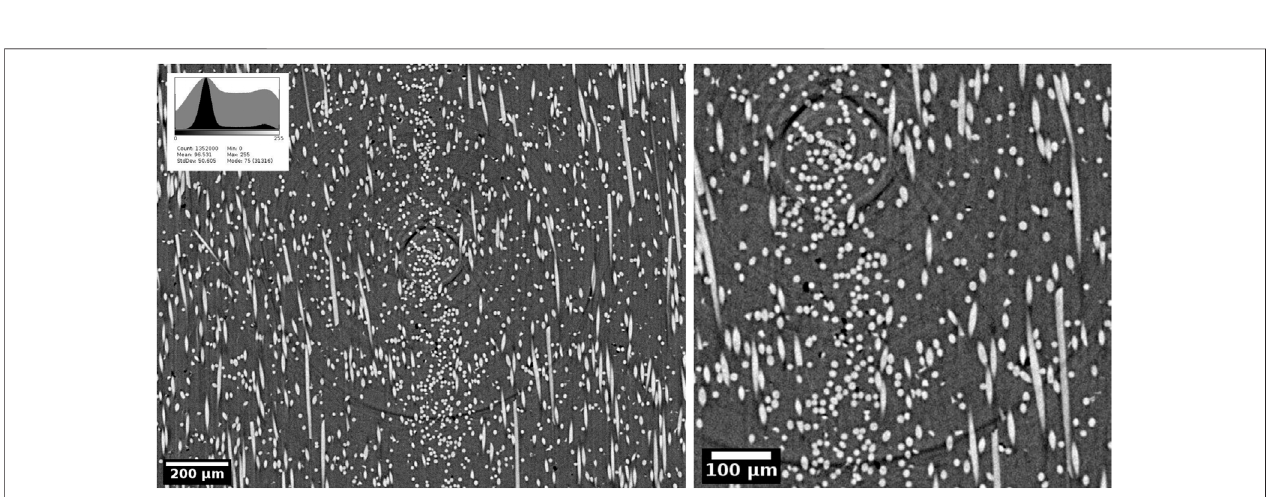
FIGURE 3 | Glass fi ber-reinforced Polyamide 66 tomography. Left: A 1300 × 1040 slice on the XY plane of the volume Train-Val-Test. In the upper left corner, a histogram of the gray level values in the image (linear scale in black, log scale in gray). Right: Zoom. Ring artifacts — from the acquisition process — can be as dark as porosities, making it harder to segment such regions.